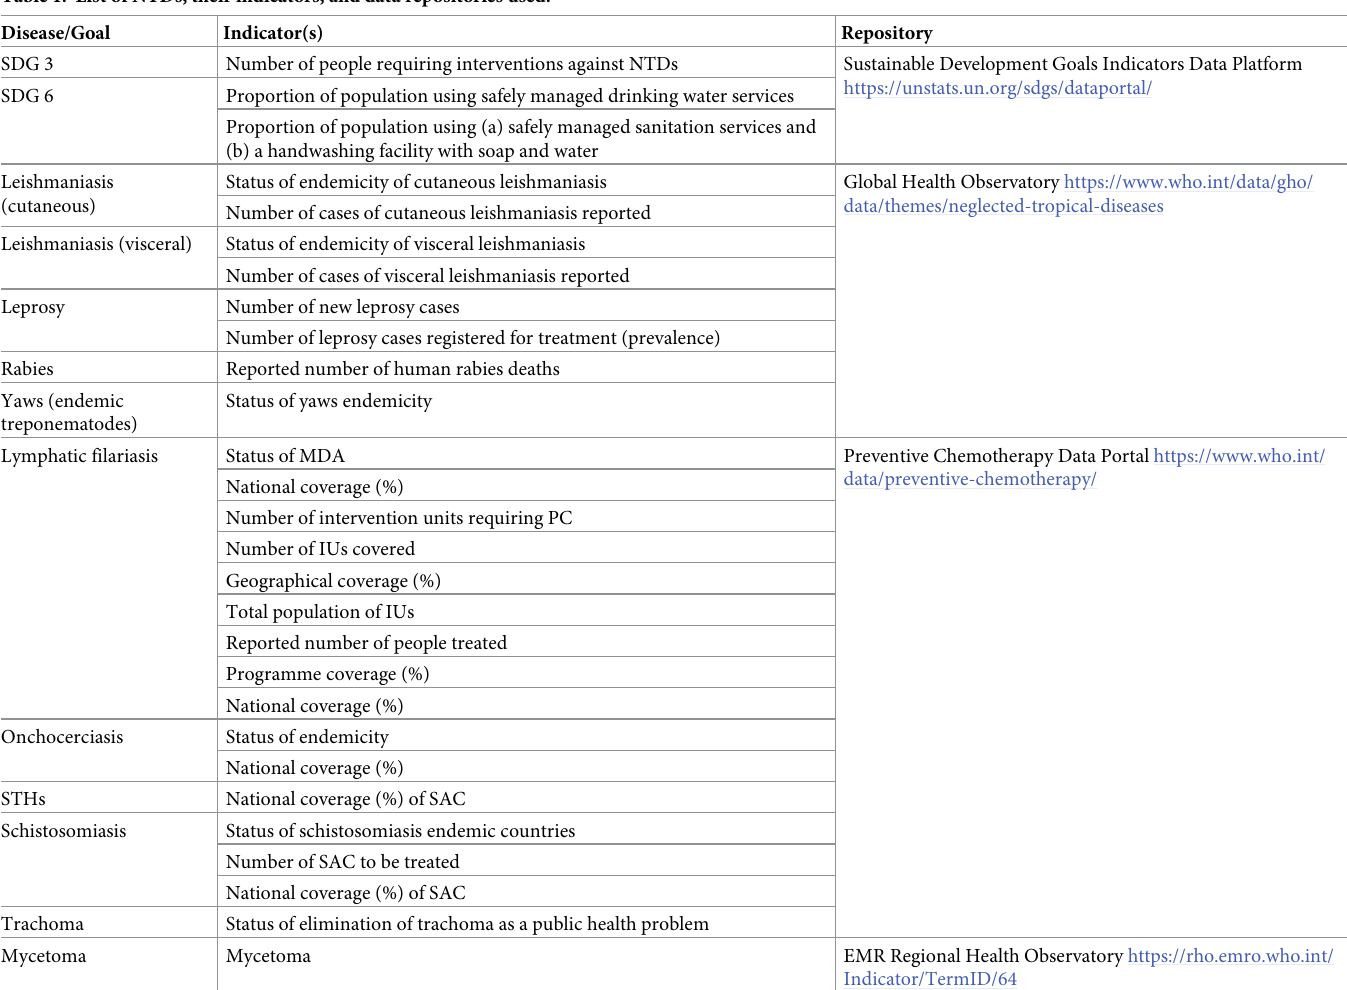
Table 1. List of NTDs, their indicators, and data repositories used.